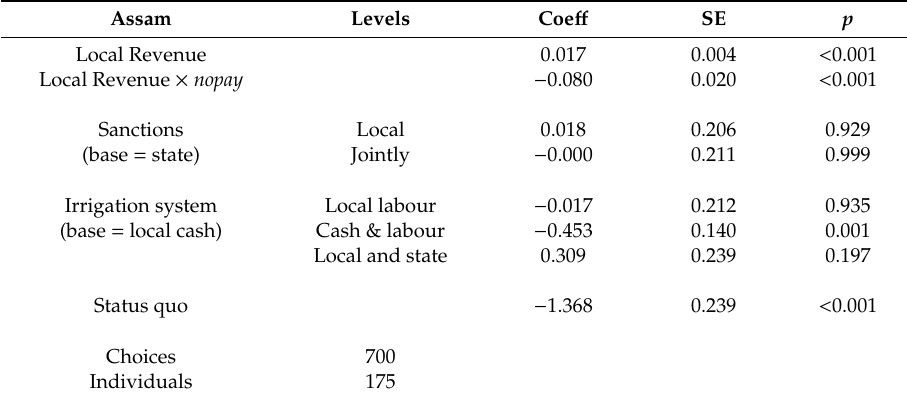
Table 12. Conditional logit estimates for preferences for governance structures: Assam.